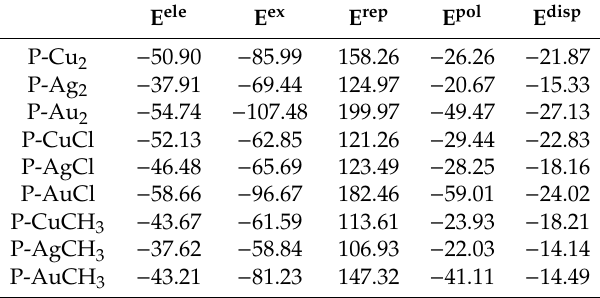
Table 4. Electrostatic energy (E ele ), exchange energy (E ex ), repulsion energy (E rep ), polarization energy (E pol ), dispersion energy (E disp ) in the binary systems at the MP2 / aug-cc-pVTZ // wB97X-D / aug-cc-pVTZ. All are in kcal / mol. E ele E